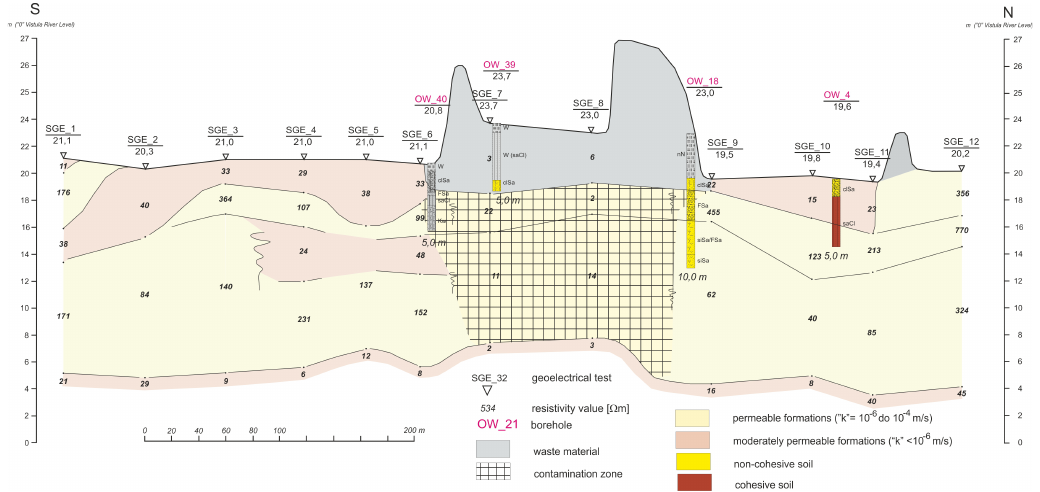
Figure 10. Geophysical cross-section of the landfill subsoil—Section